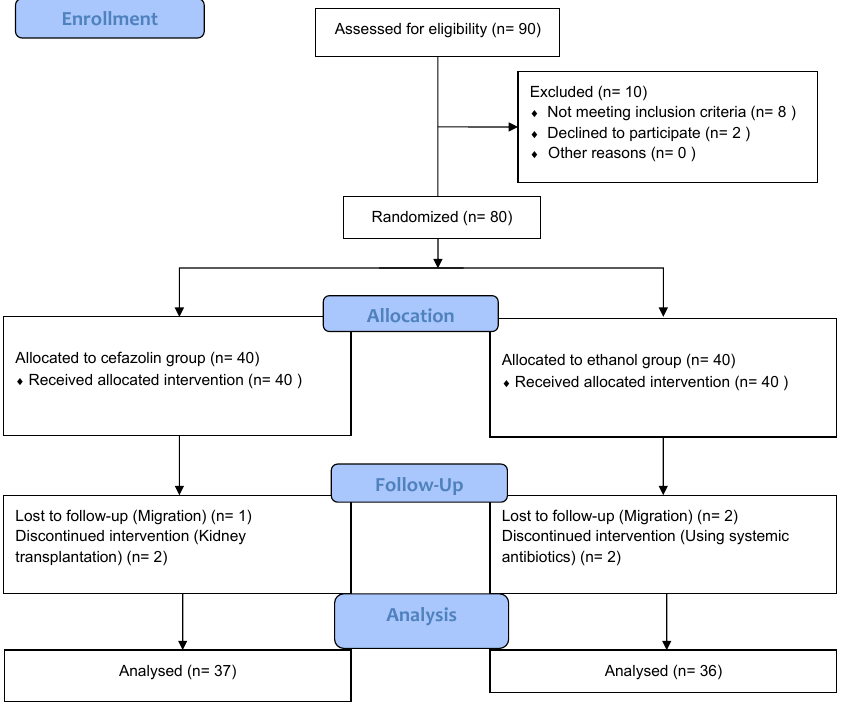
Figure 1. CONSORT flow chat diagram.